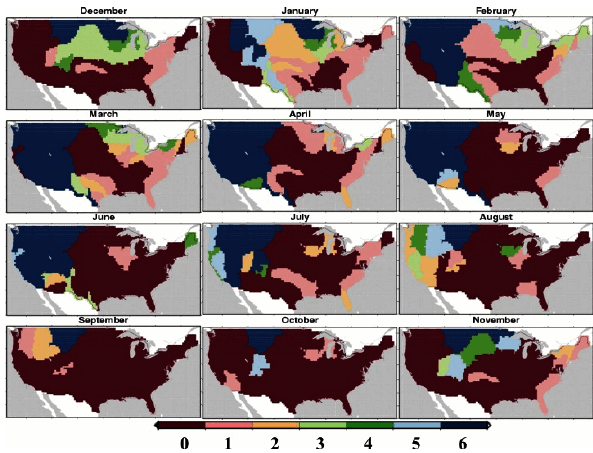
Fig. 4. Plot of the maximum lead (in months) at which RMSE Ratio is less than 1, for CR forecasts, initialized on the beginning of each